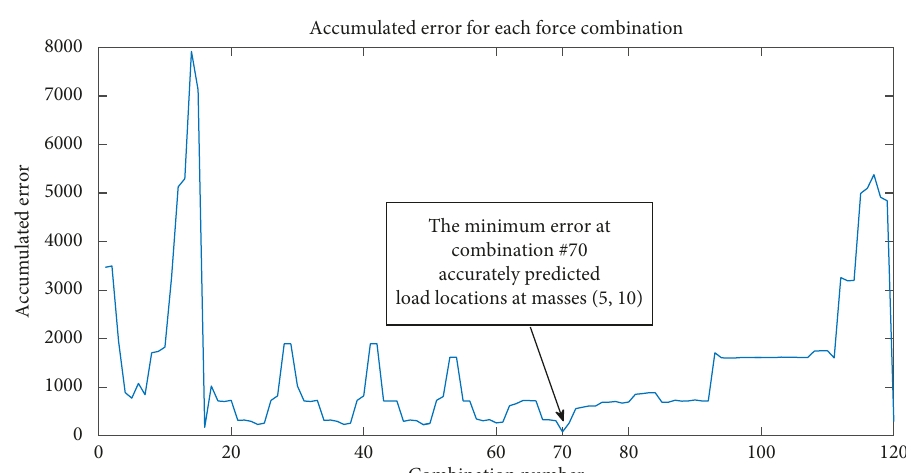
Figure 8: Applied and reconstructed load at mass 10.